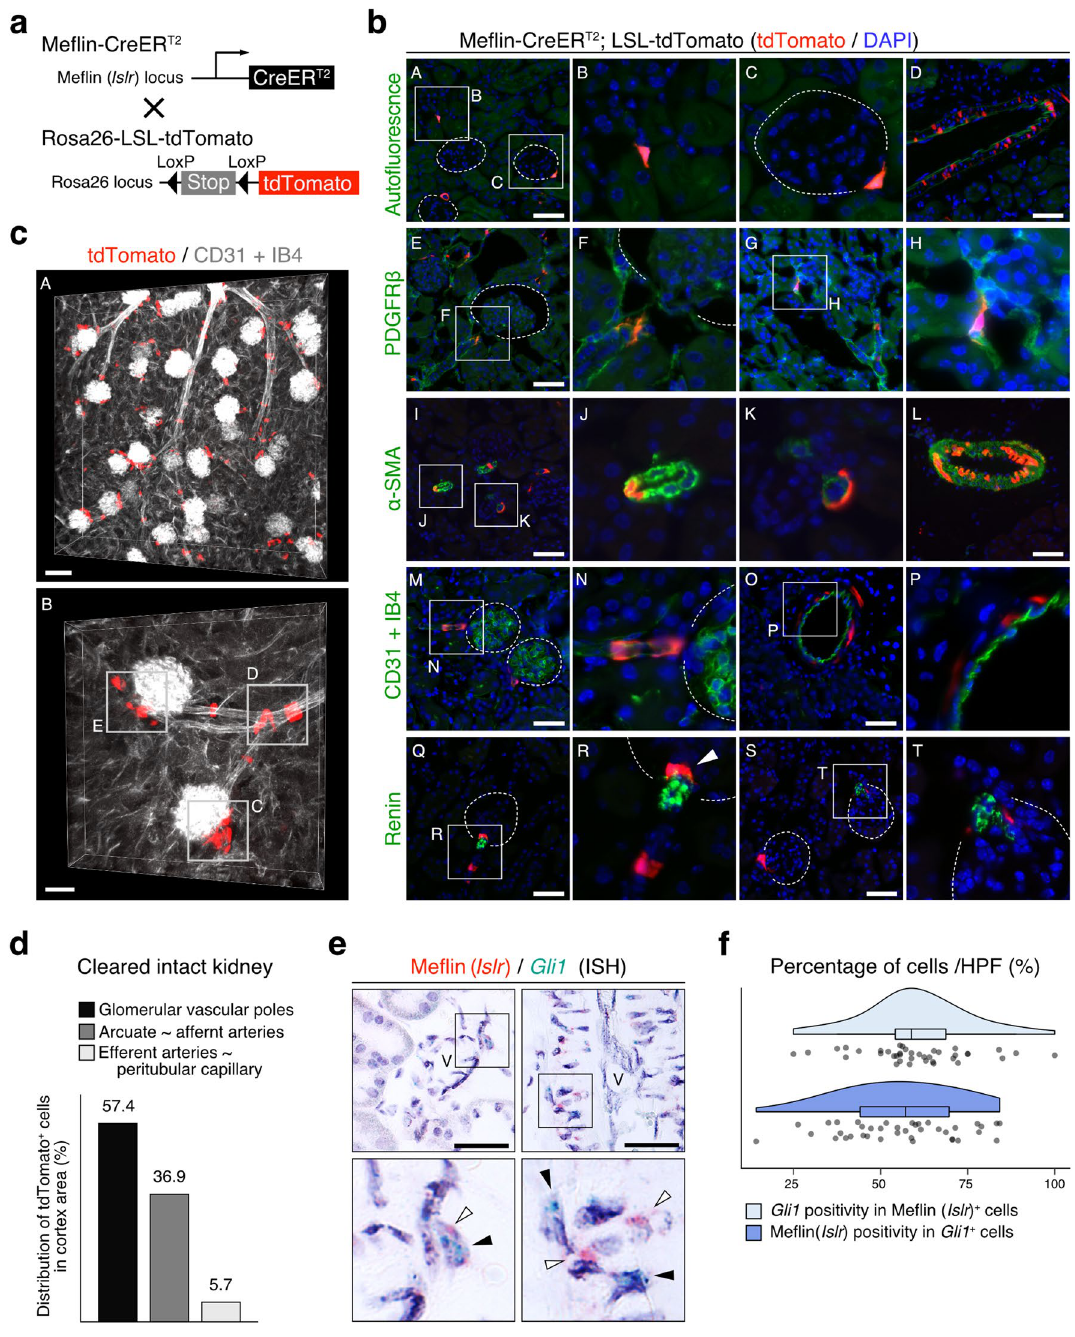
Figure 1. Distribution of Meflin + cells in the normal kidney. ( a ) Meflin-CreER T2 mice were crossed with Rosa26-LSL-tdTomato mice, followed by TAM administration (i.p., 0.1 mg/g; 10 times) to evaluate Meflin + (tdTomato + ) cells. ( b ) Frozen kidney tissue sections prepared from Meflin-CreER T2 ; LSL-tdTomato mice were stained for PDGFRβ, ɑ -SMA, CD31, IB4, and renin (green). Circles surrounded by dotted lines indicate glomeruli. White arrowhead in R indicates tdTomato + /renin + cells. Scale bar, 50 µm. ( c ) Kidney tissue clearing of kidney of Meflin-CreER T2 ; LSL-tdTomato mice showed Meflin + cells surrounding the vasculatures. Scale bar, 80 ( A ) and 40 ( B ) µm. Boxed regions ( C–E ) indicate tdTomato + cells around glomerular vascular poles, afferent arteries, and efferent arteries, respectively. ( d ) Distribution of tdTomato + cells (244 cells) in the cleared renal cortex was evaluated, followed by quantification. ( e,f ) Adult mouse kidney sections were double stained for Meflin ( Islr , red) and Gli1 (green) by duplex ISH. White and black arrowheads indicate Meflin ( Islr ) and Gli1 signals, respectively. Boxed areas were magnified in lower panels. Scale bar, 50 µm. V, small vessels. Raincloud plots ( f ) showing the percentage of Gli1 + cells in all Meflin ( Islr ) + cells (upper plot) and Meflin ( Islr ) + cells in all Gli1 + cells (lower plot). A total of 39 high-power fields (400×) from three samples were evaluated. Data were analyzed and visualized using R software 47